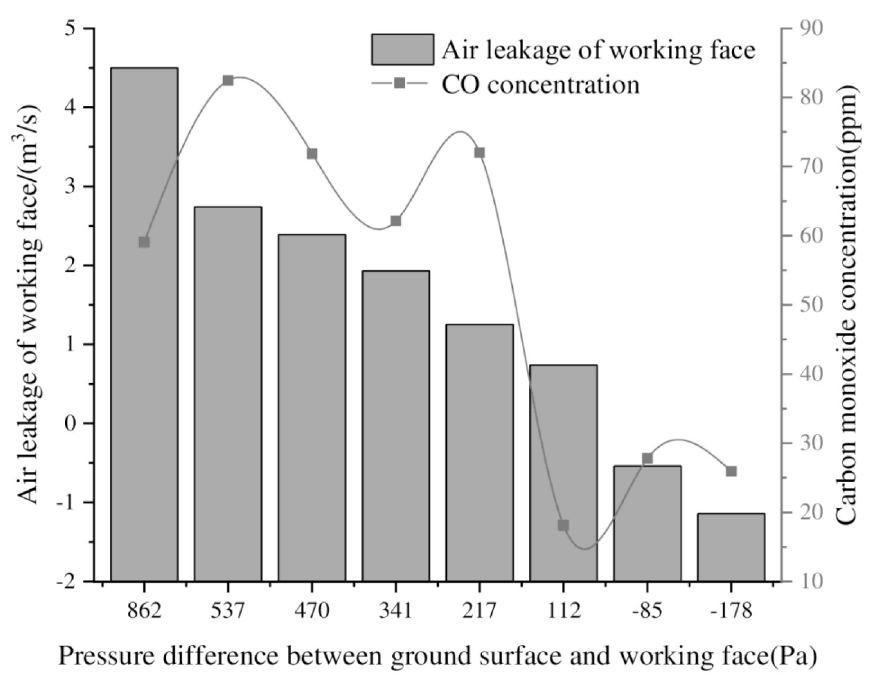
Fig 13. Air leakage of the working face and upper corner CO concentration during pressurization.